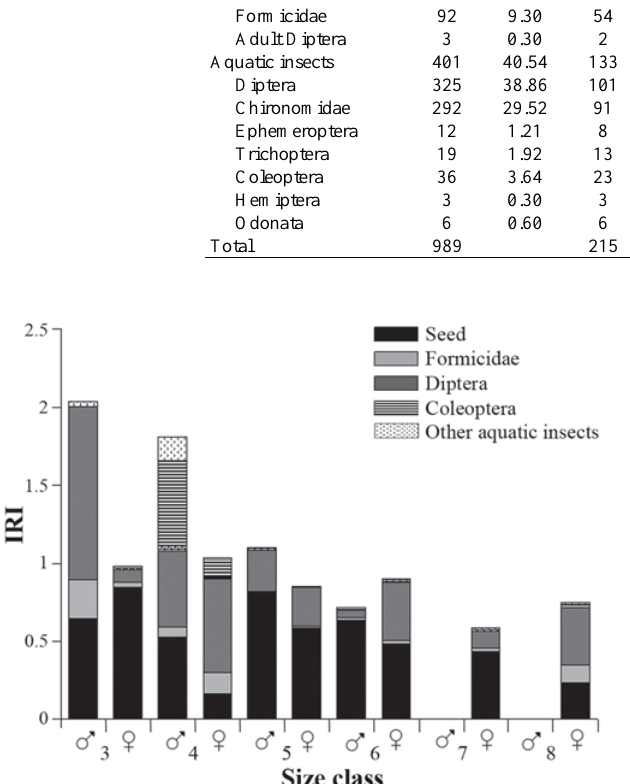
Fig. 1. Ontogenetic and intersexual variation in the diet of Creagrutus guanes . Size classes correspond to standard length ranges: 3 = 21-30 mm; 4 = 31-40 mm; 5 = 41-50 mm; 6 = 51-60 mm; 7 = 61-70mm; 8 = 71-80mm.